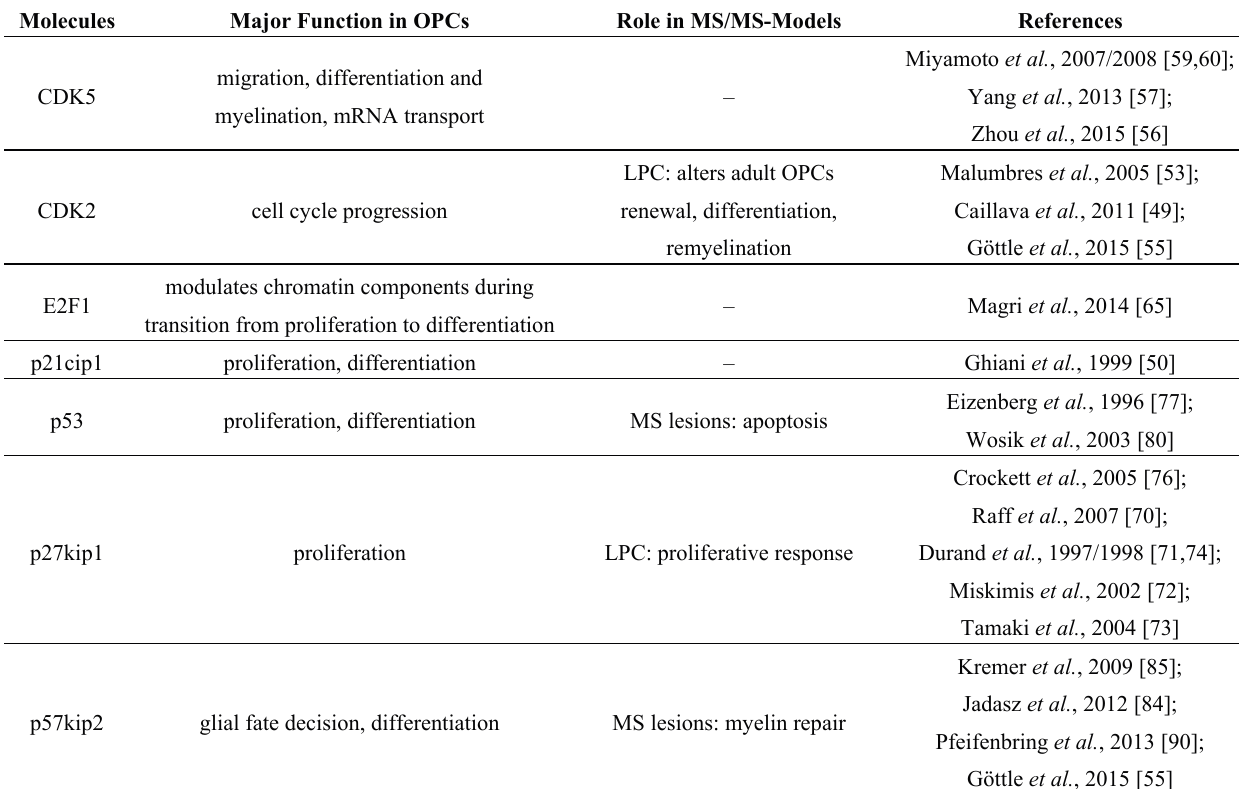
Table 1. Cell cycle-associated key